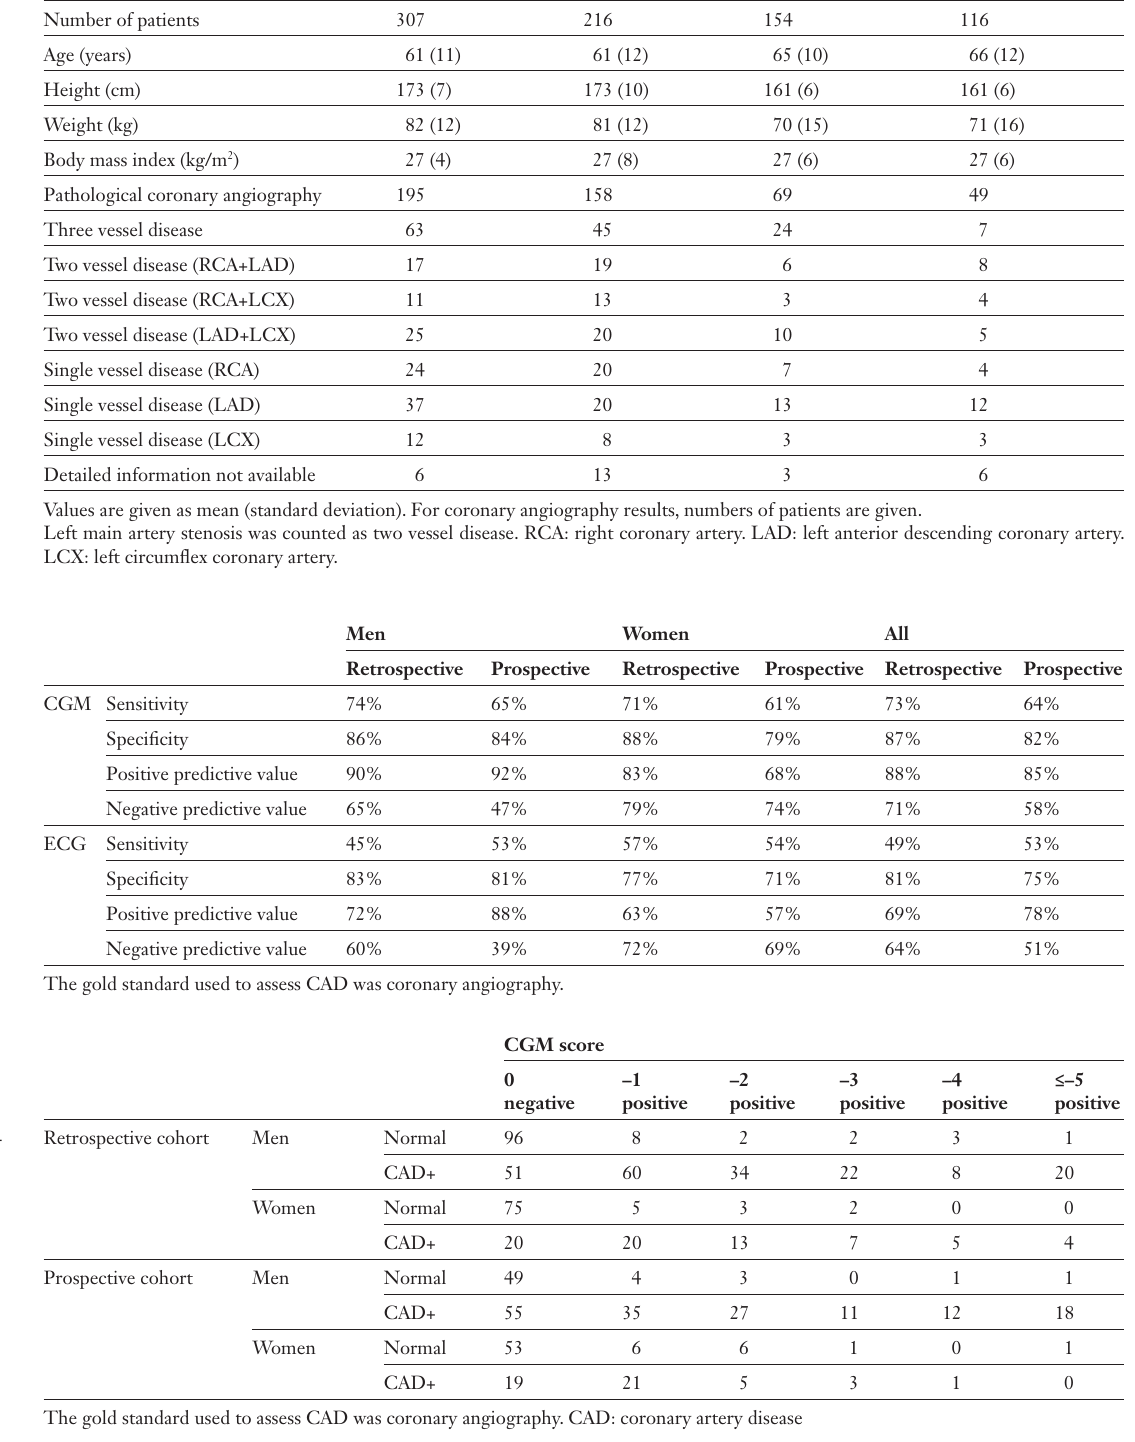
Patient characteristics and results of coro- nary angiography.